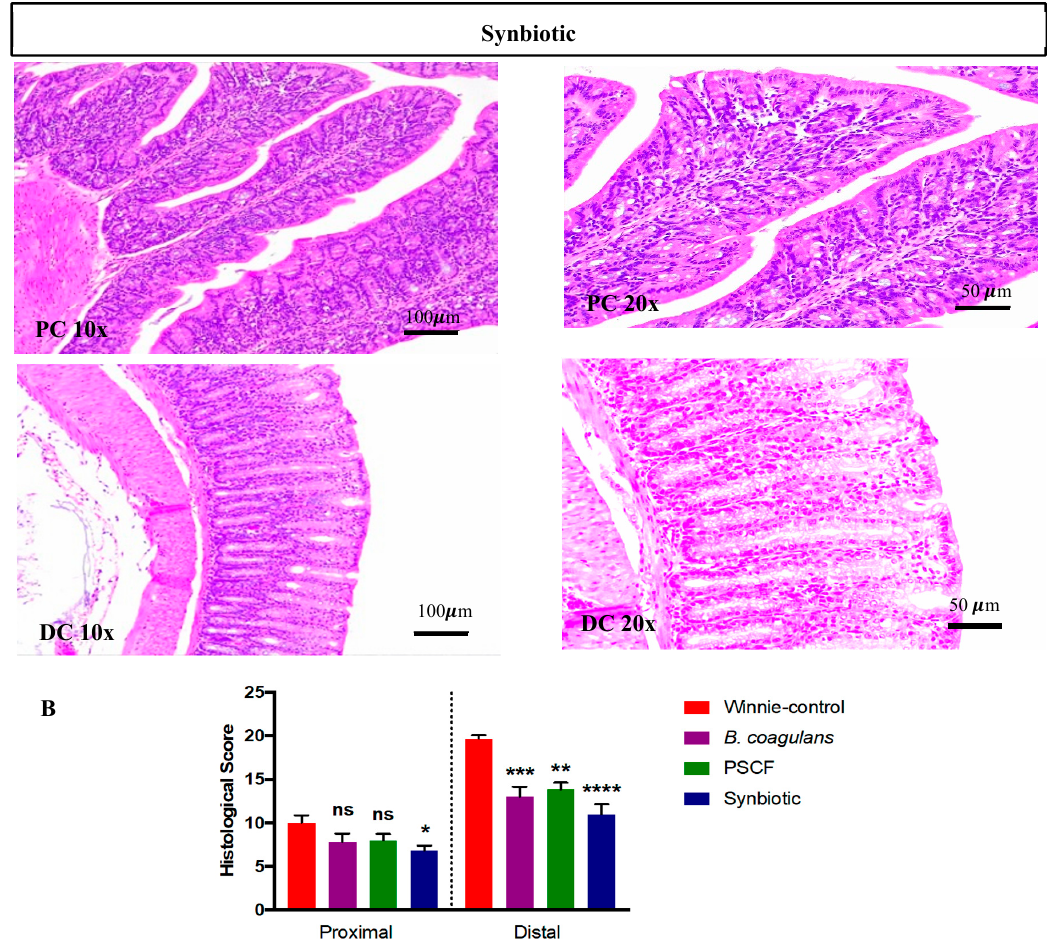
Figure 3. E ff ect of B. coagulans spores, PSCF and Synbiotic treatments on colon injury and inflammation in chronic-colitic-Winnie mice. ( A ) Histological images of proximal colon (PC) and distal colon (DC) tissues stained with hematoxylin and eosin at 10 × and 20 × for each experimental group. ( B ) Histological score calculated after microscopic analyses of proximal and distal sections of the colon. Results expressed as mean ± SEM ( n = 6 per group), evaluated by one-way ANOVA (* p < 0.05, ** p < 0.01, *** p < 0.001, **** p < 0.0001).